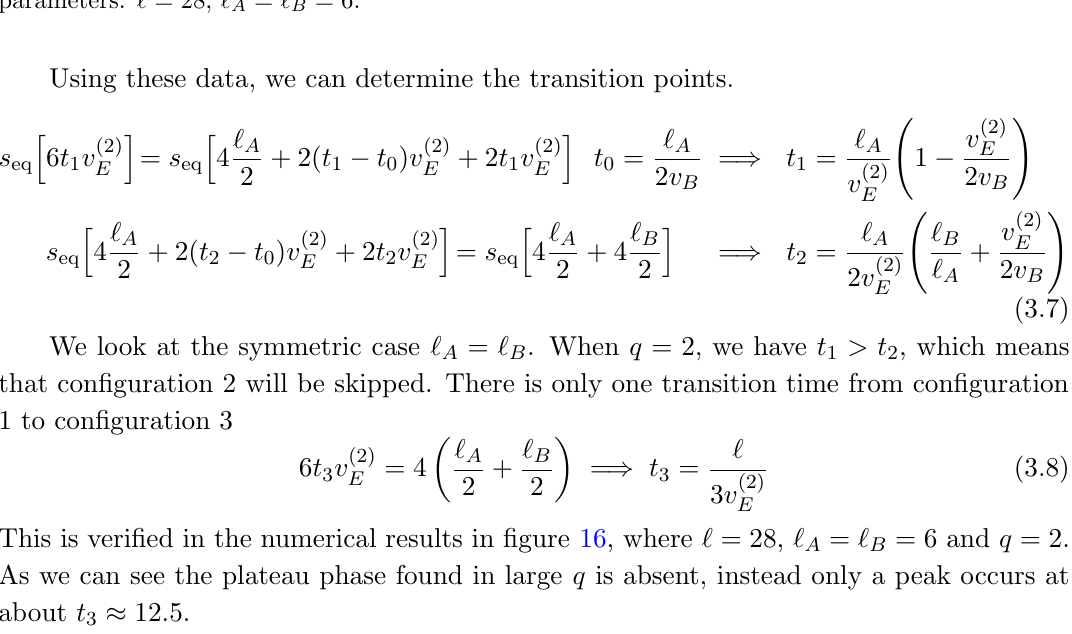
Figure 16 . Numerical results of random unitary circuit at q = 2 averaged over 10 samples. System parameters: ‘ = 28, ‘ A = ‘ B =